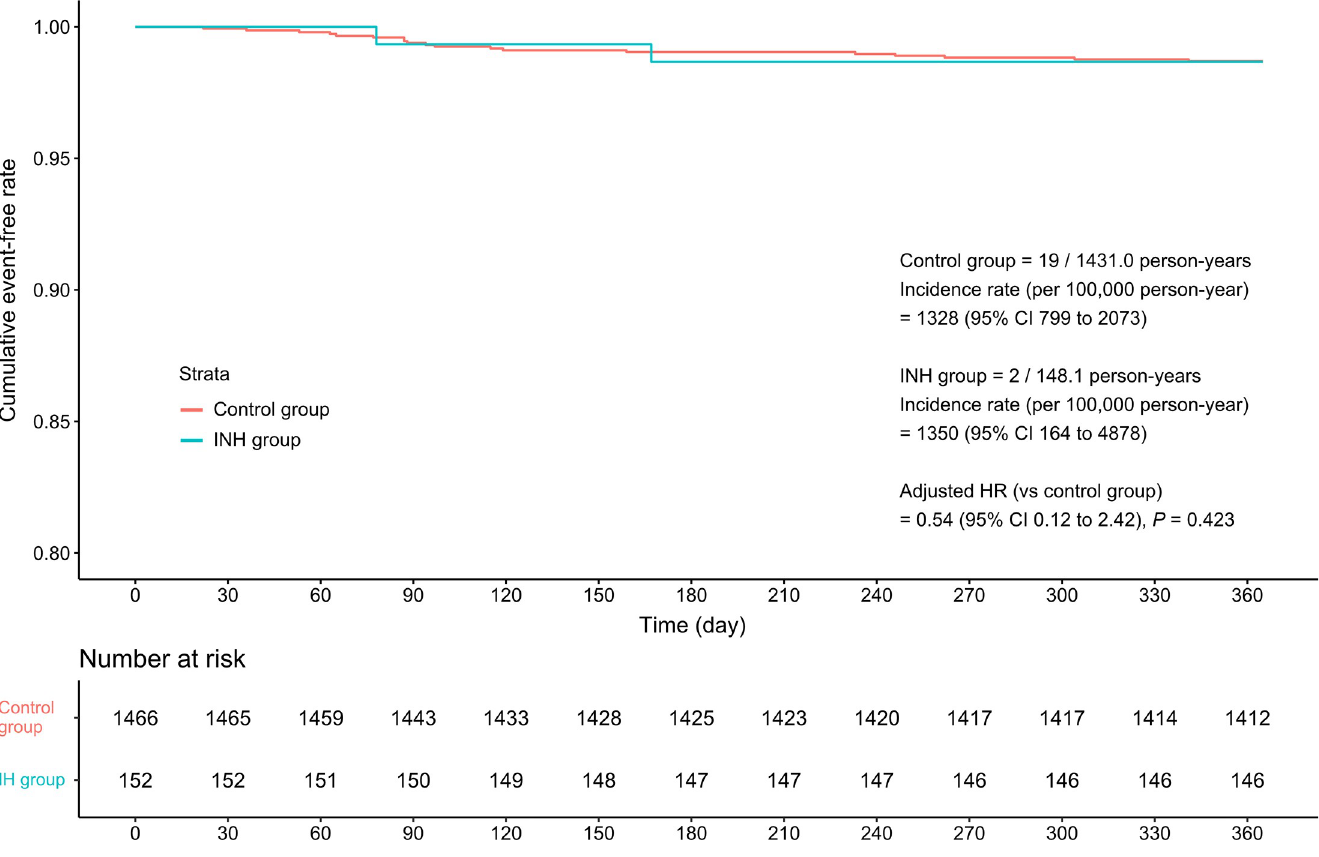
Fig 2. Kaplan–Meier curves indicating the 1-year tuberculosis incidence in the control and INH groups.